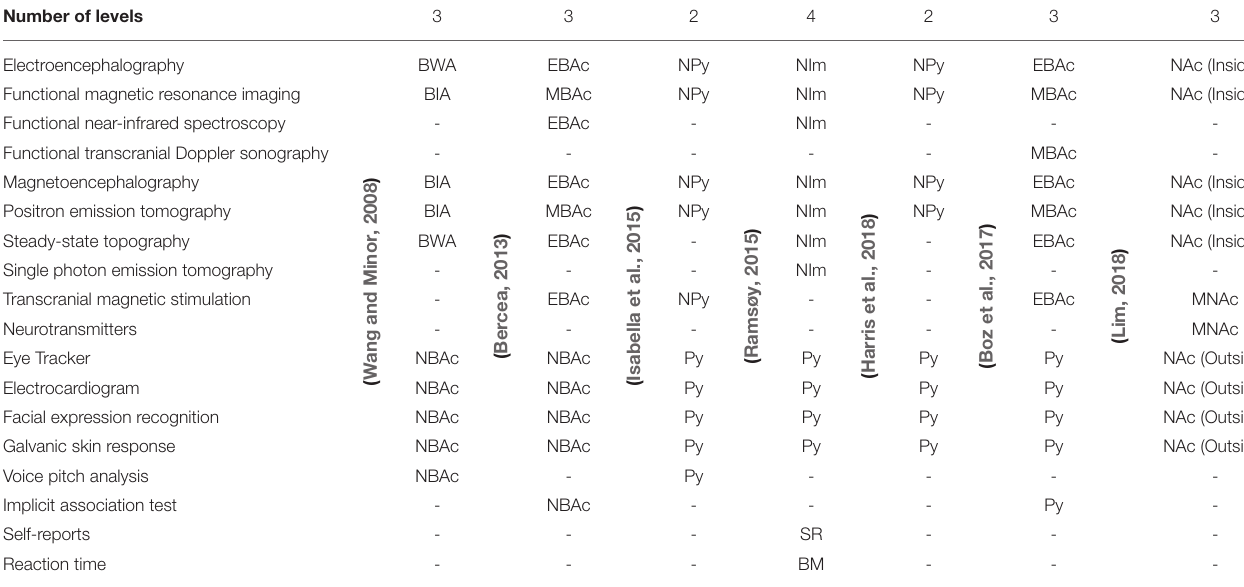
TABLE 1 | Classification of consumer neuroscience tools. Number of